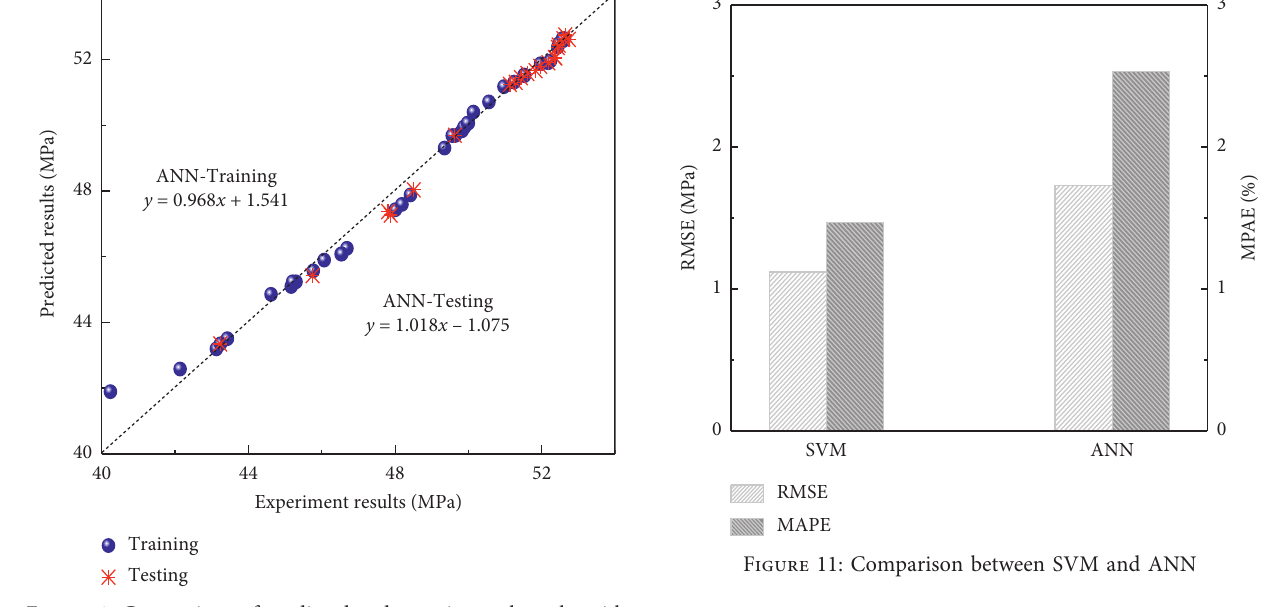
Figure 9: Comparison of predicted and experimental results with training and testing.